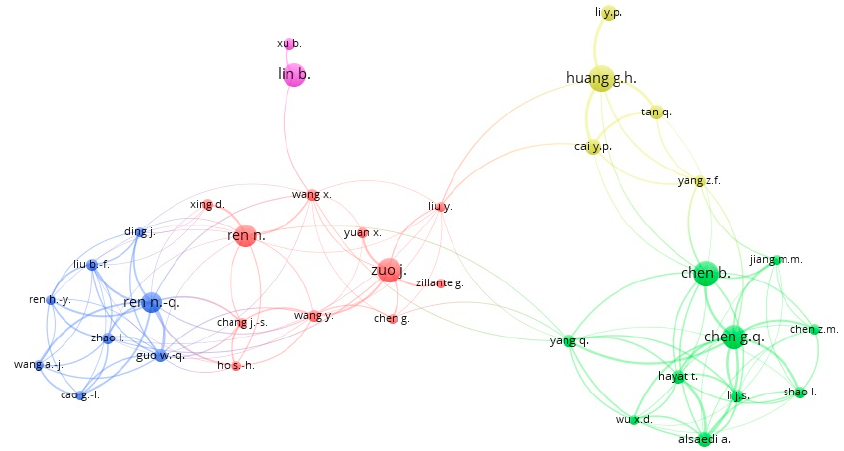
Figure 12. Co-authorship network. Table 5. List of the 40 most used keywords.